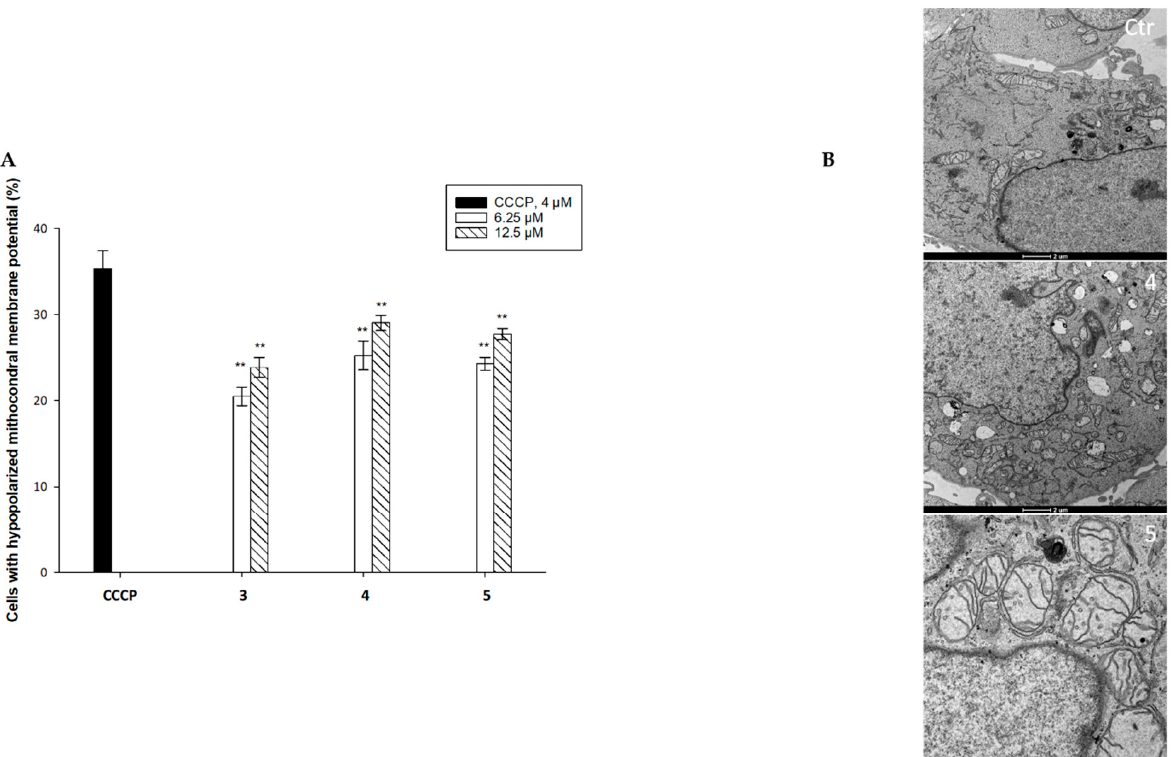
Figure 4. Antimitochondrial effect. ( A ) U1285 cells were treated for 24 h with increasing concentrations of the tested complexes or CCCP (3 µM). The percentage of cells with hypopolarized mitochondrial membrane potential was determined by Mito-ID ® Membrane Potential Kit. **p ≤ 0.01. Error bars indicate S.D. ( B ) TEM analysis. Transmission electron micrographs of untreated U1285 cells or 24 h treated cells with IC 50 concentrations of complex 3 or complex 4 .